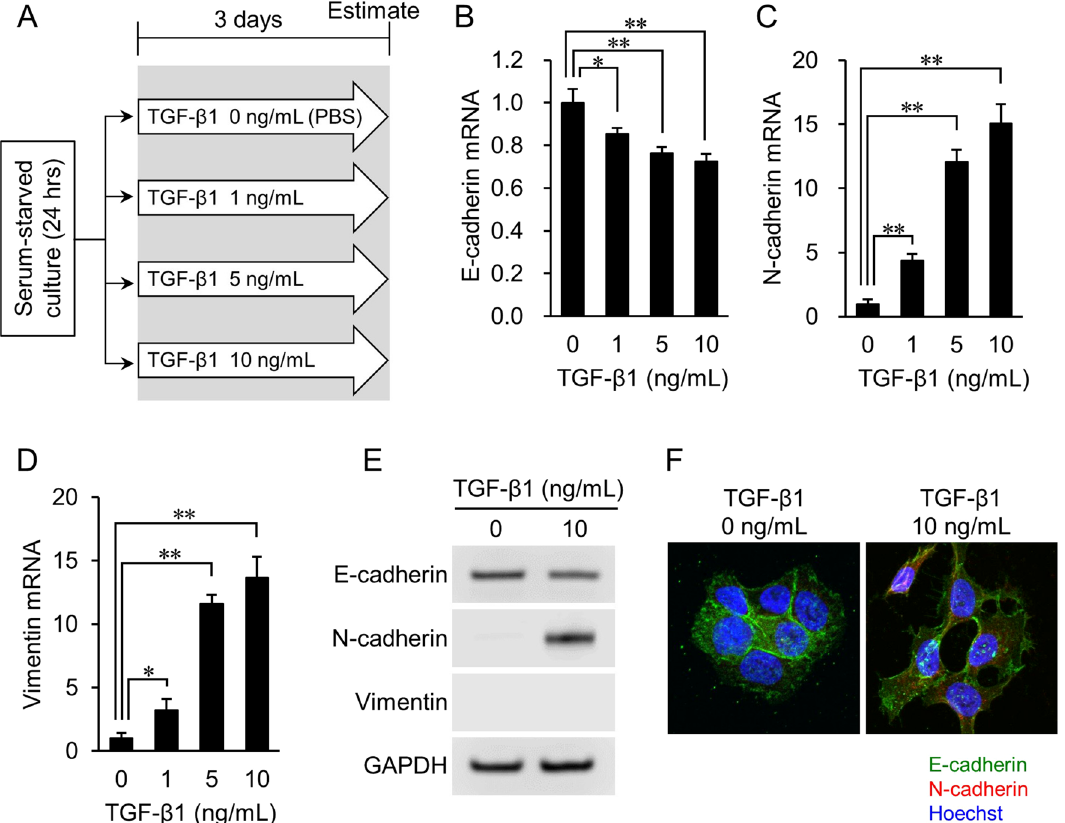
Figure 1. Expression of EMT markers in NCI-H322M cells treated with TGF-β1. ( A ) Overview of experimental procedures. ( B–D ) Quantitative PCR analysis of E-cadherin ( B ), N-cadherin ( C ), and vimentin ( D ) mRNA expression in cells treated with TGF-β1. Data are normalized to 18S rRNA level in each sample and are expressed as values relative to that of the internal control. RNA isolated from cells cultured without TGF-β1 is used as control. The measurement values for each group are compared using the Bonferroni-Dunn post-hoc test. Mean ± SD, n = 3, * p < 0.05, ** p < 0.01; Comparison with TGF-β1 (−) control (0 ng/mL). ( E ) Protein levels of E-cadherin, N-cadherin, and vimentin are determined by western blot analyses. GAPDH expression is used as a loading control. Representative images from three independent experiments are shown. ( F ) Immunofluorescence staining images of EMT markers. E-cadherin (green), N-cadherin (red), and cell nuclei (blue, Hoechst staining) are shown. N-cadherin expression is only observed in TGF-β1 induced